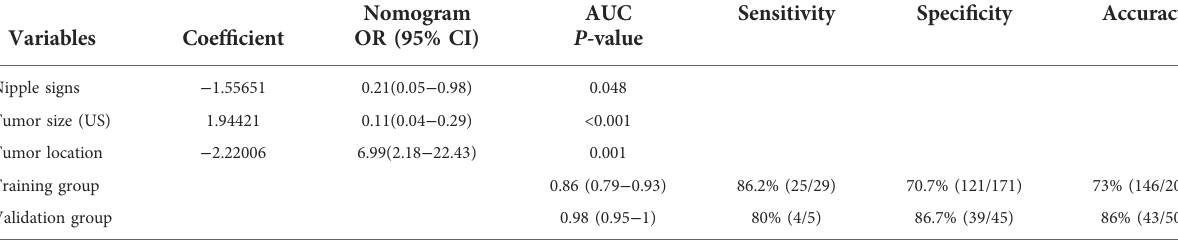
TABLE 2 Results of multivariate logistic regression models.